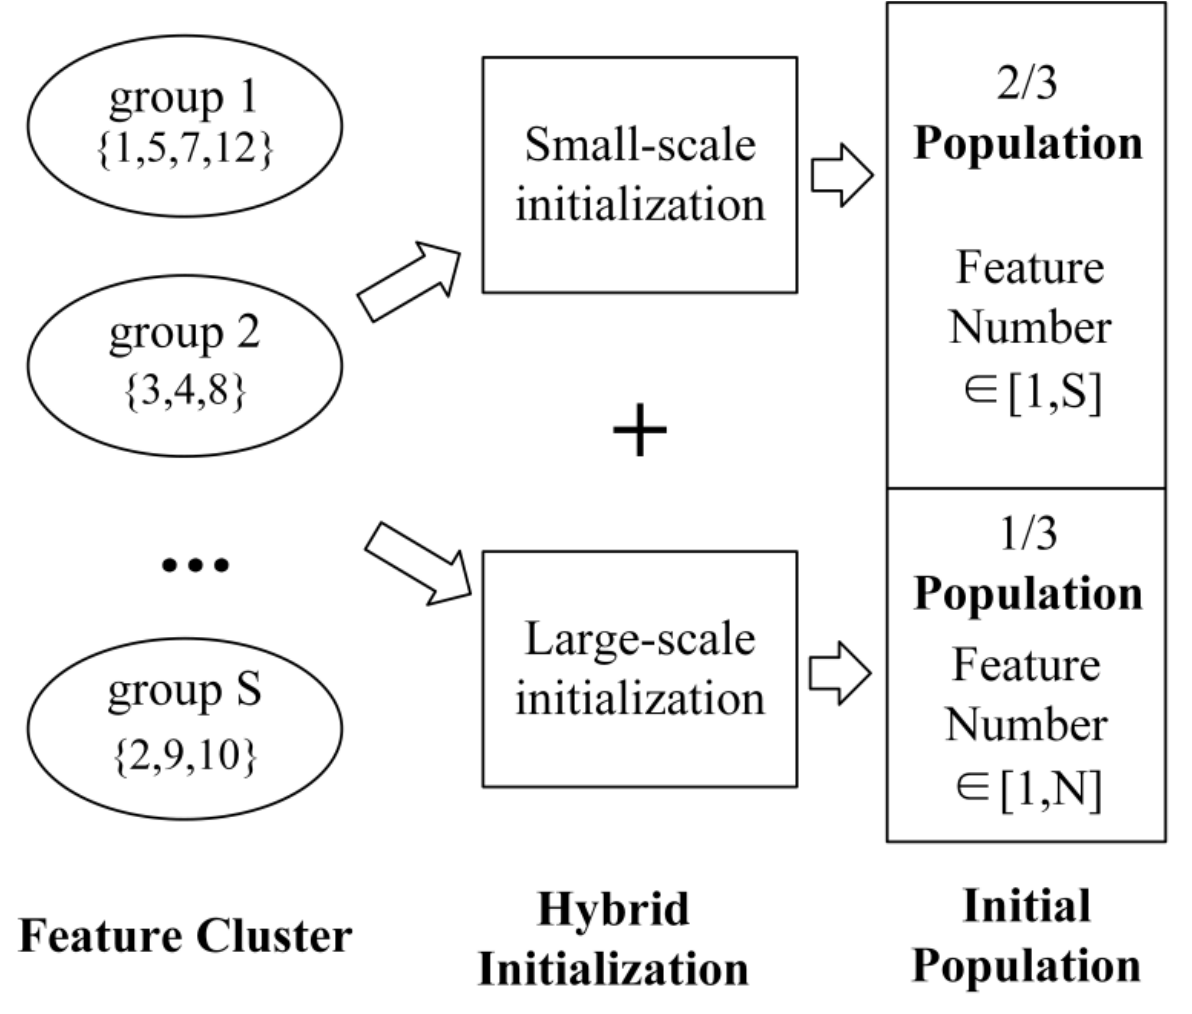
Figure 4. Flowchart of the clustering hybrid initialization method.